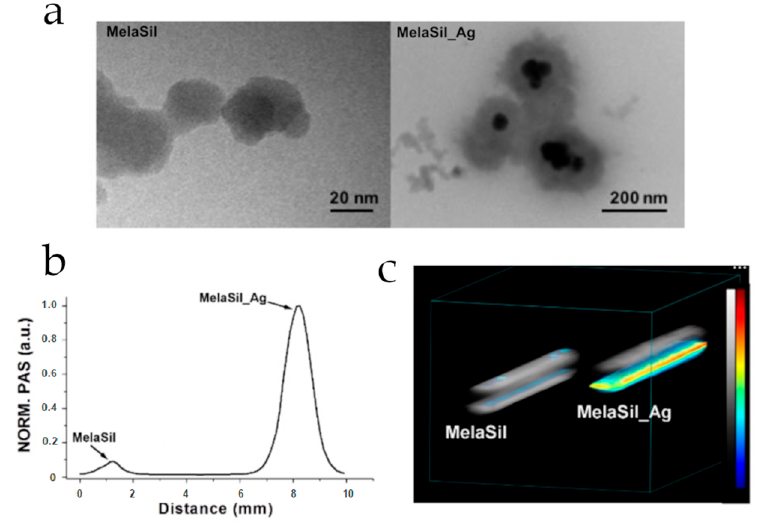
Figure 6. Transmission electron microscopy (TEM) of both melanin-silica (MelaSil) and Ag-melanin-silica hybrid (MelaSil_Ag) photoacoustic nanoprobes ( a ) Comparison of normalized mean photoacoustic signal ( b ) and 3D photoacoustic-ultrasound render ( c ) produced by nanoparticles with and without Ag components; in grayscale, the intensity of the ultrasound signal, whereas in colored scale, intensity of photoacoustic signal. Reproduced with permission from [51] Copyright Elsevier, 2019.